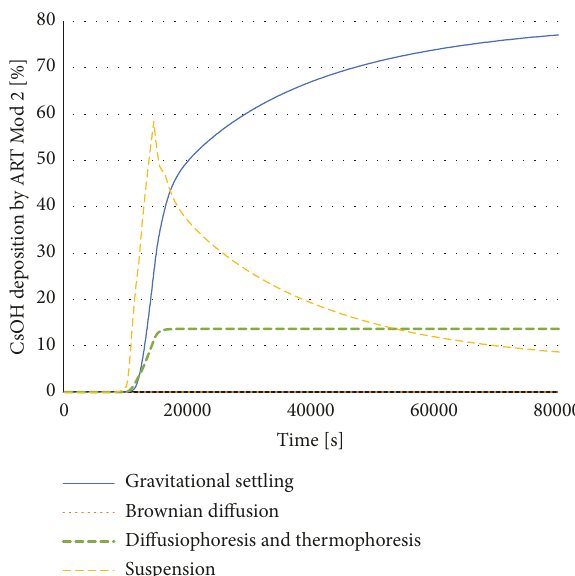
Figure 18: CsOH deposition from combination of calculations of all single volumes calculated by ART Mod 2.